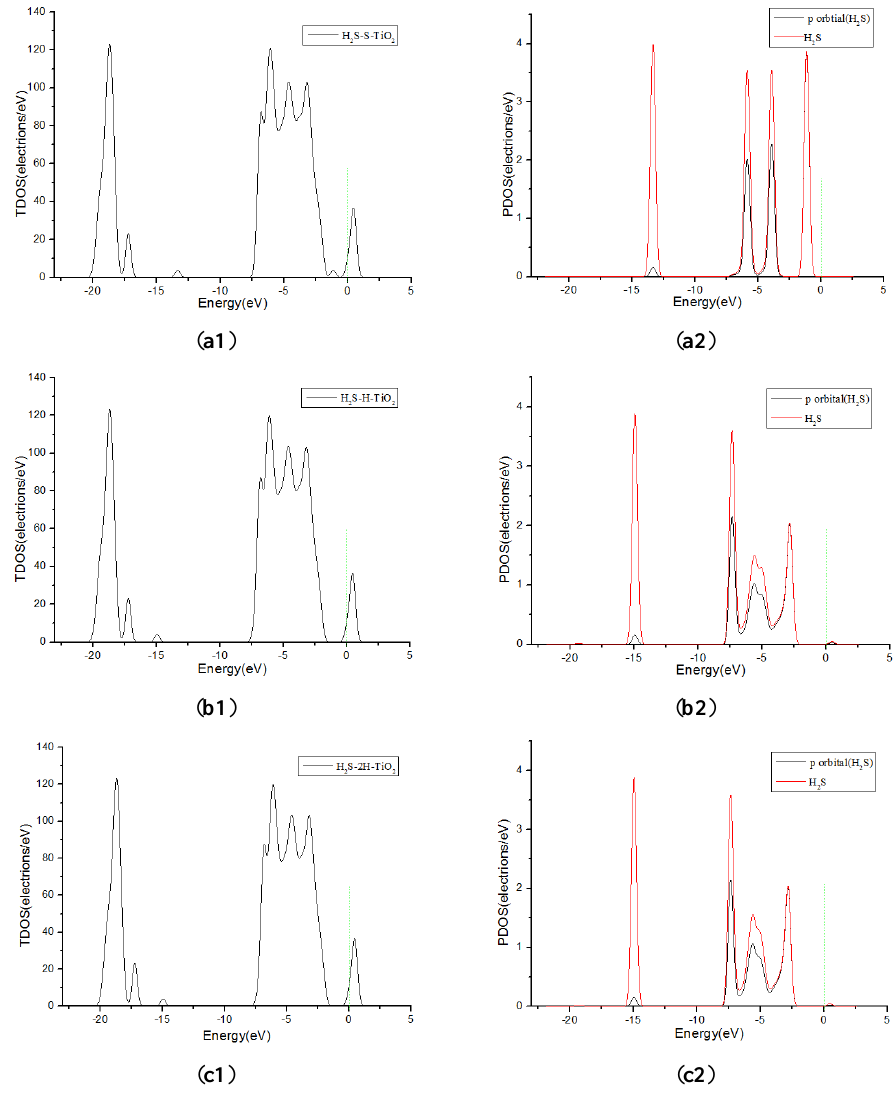
Figure 6. TDOS and PDOS of H 2 S molecules adsorbed onto F-doped TiO 2 , and the green short dashed line is Fermi level. ( a1 , a2 ) are the TDOS and PDOS of H 2 S-S-TiO 2 , ( b1 , b2 ) are the TDOS and PDOS of H 2 S-H-TiO 2 , ( c1 , c2 ) are the TDOS and PDOS of H 2 S-2H-TiO 2 .